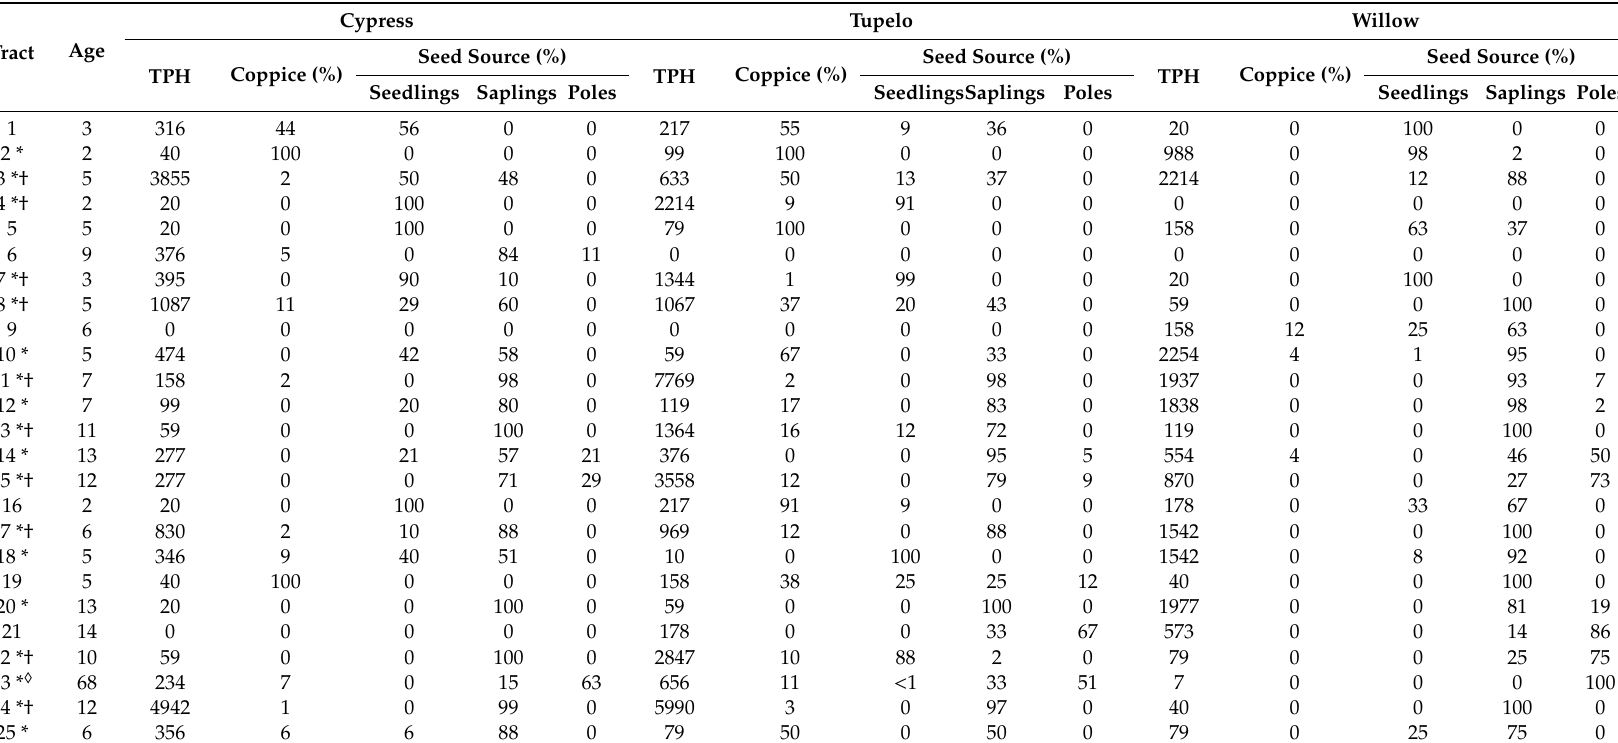
Table 3. Stand age, trees per hectare (TPH), and percent of TPH categorized as coppice and seed source by cypress ( Taxodium distichum ), tupelo ( Nyssa species), and black willow ( Salix nigra ) for each of the 25 tracts